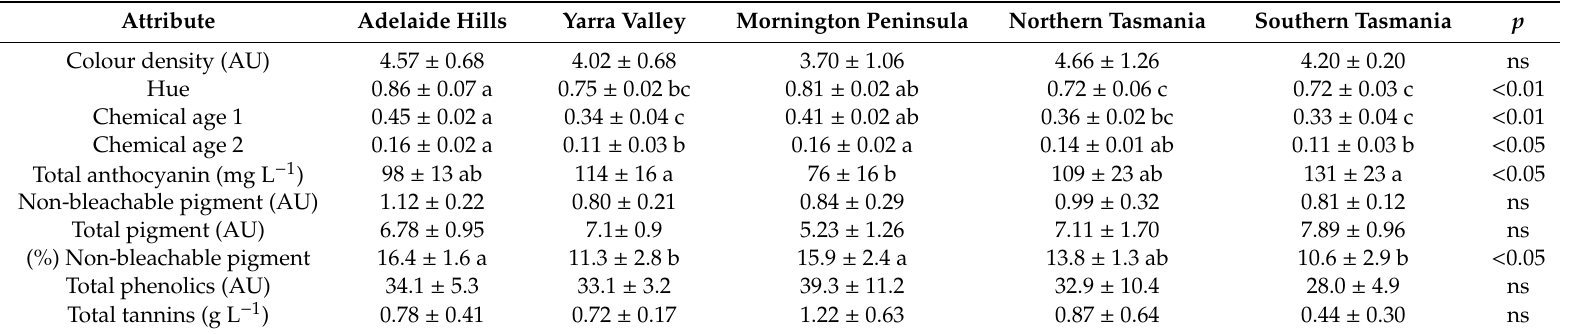
Table 4. Mean ( ± SD) of chromatic and colour structure measurements of 2018 Pinot noir wines ( n = 3 per region).